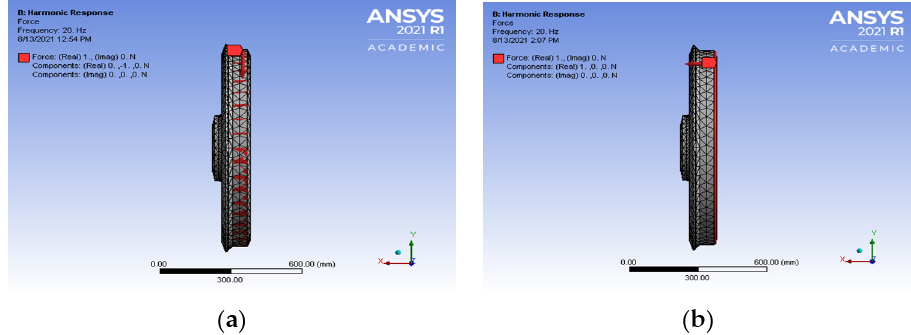
Figure 7. Finite element model of the wheel: ( a ) radial excitation and ( b ) lateral excitation.